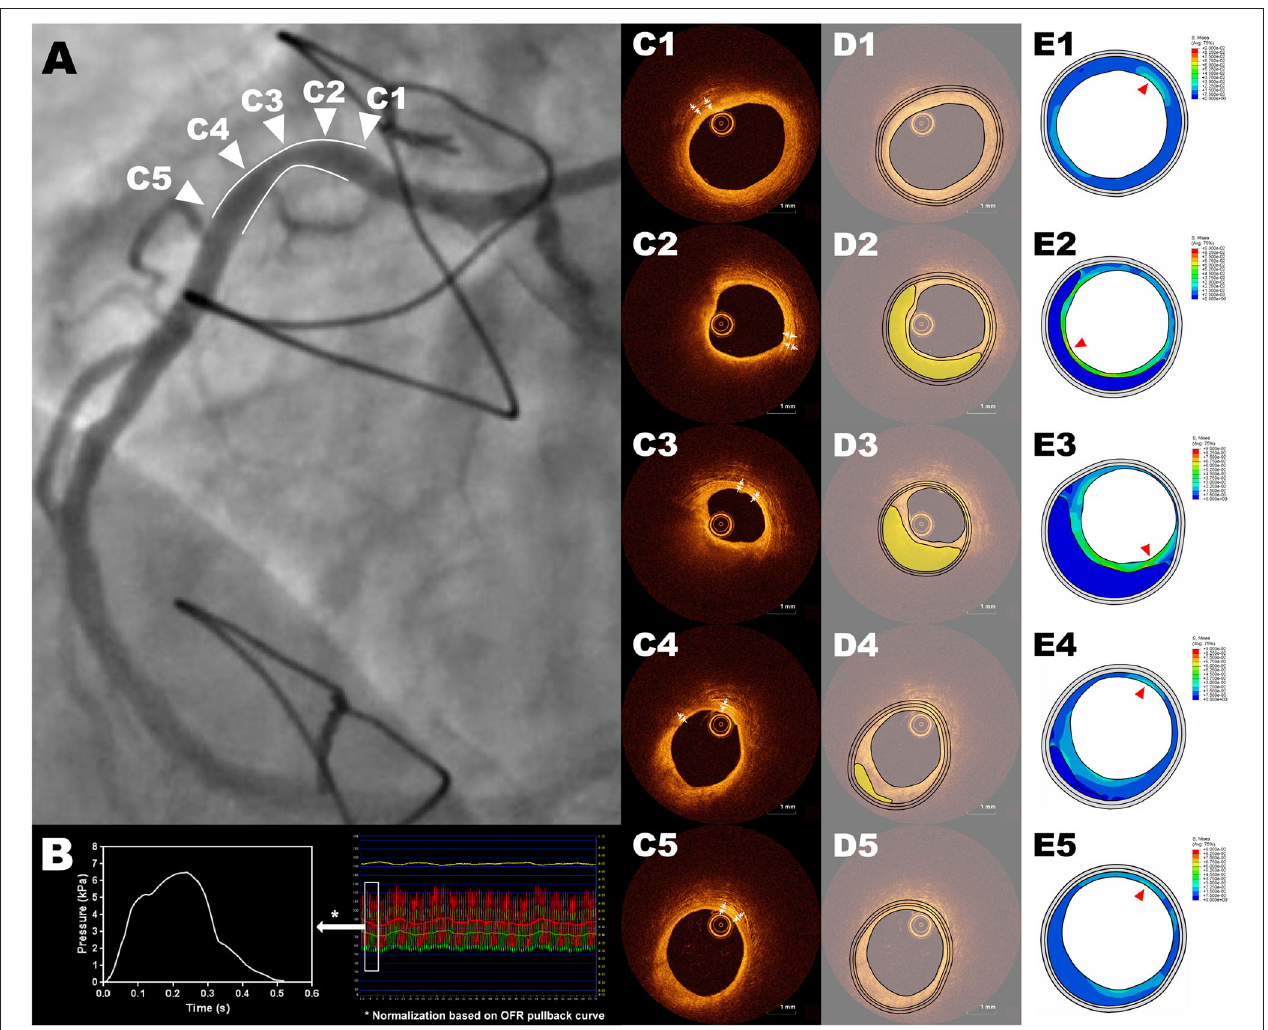
FIGURE 1 | Representative example of 1 PSS analysis of an intermediate RCA lesion. Cross-sections (C1-C5) correspond to the five representative positions in the angiography showed in panel (A) , with (C1) as the cross-section of proximal reference, (C2 ) as the cross-section of proximal shoulder, (C3) as the cross-section of minimal lumen area, (C4) as the cross-section of distal shoulder and (C5) as the cross-section of distal reference. The 2-dimensional FEA model is loaded with the position-specific intracoronary pressure derived from intracoronary tracing data, by normalizing the computed OFR pullback curve between the resting aortic pressure tracing data and distal coronary pressure tracing data (B) . The three-layer geometric models were reconstructed based on an automatic plaque delineation algorithm (18) (D1–D5) , where the lipidic plaque is shown in yellow. The thicknesses of media and adventitia were manually measured from OCT cross-sections (C1–C5) . (E1–E5) show the stress distribution with the red triangles pointing the positions with largest 1 PSS. FEA, finite element analysis; RCA, right coronary artery; OCT, optical coherence tomography; OFR, optical flow ratio; 1 PSS, delta plaque structural